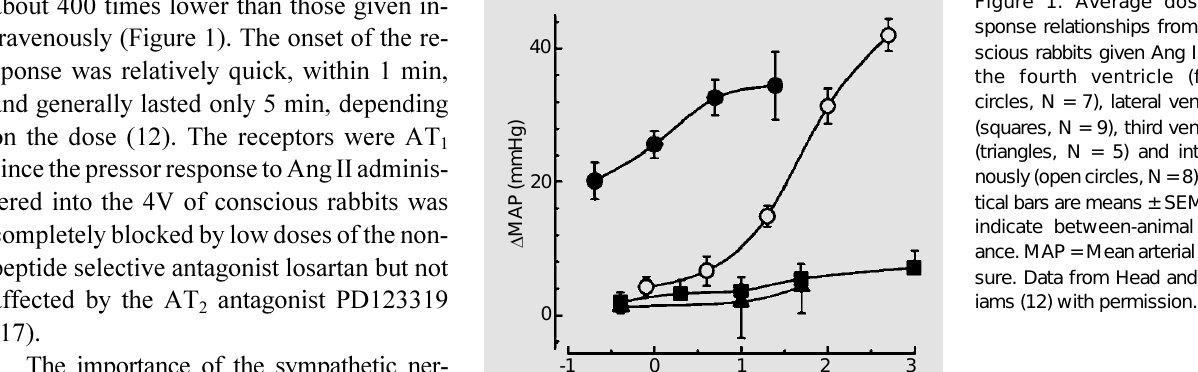
Figure 1. Average dose-re- sponse relationships from con- scious rabbits given Ang II into the fourth ventricle (filled circles, N = 7), lateral ventricle (squares, N = 9), third ventricle (triangles, N = 5) and intrave- nously (open circles, N = 8). Ver- tical bars are means ± SEM and indicate between-animal vari- ance. MAP = Mean arterial pres- sure. Data from Head and Will- iams (12) with